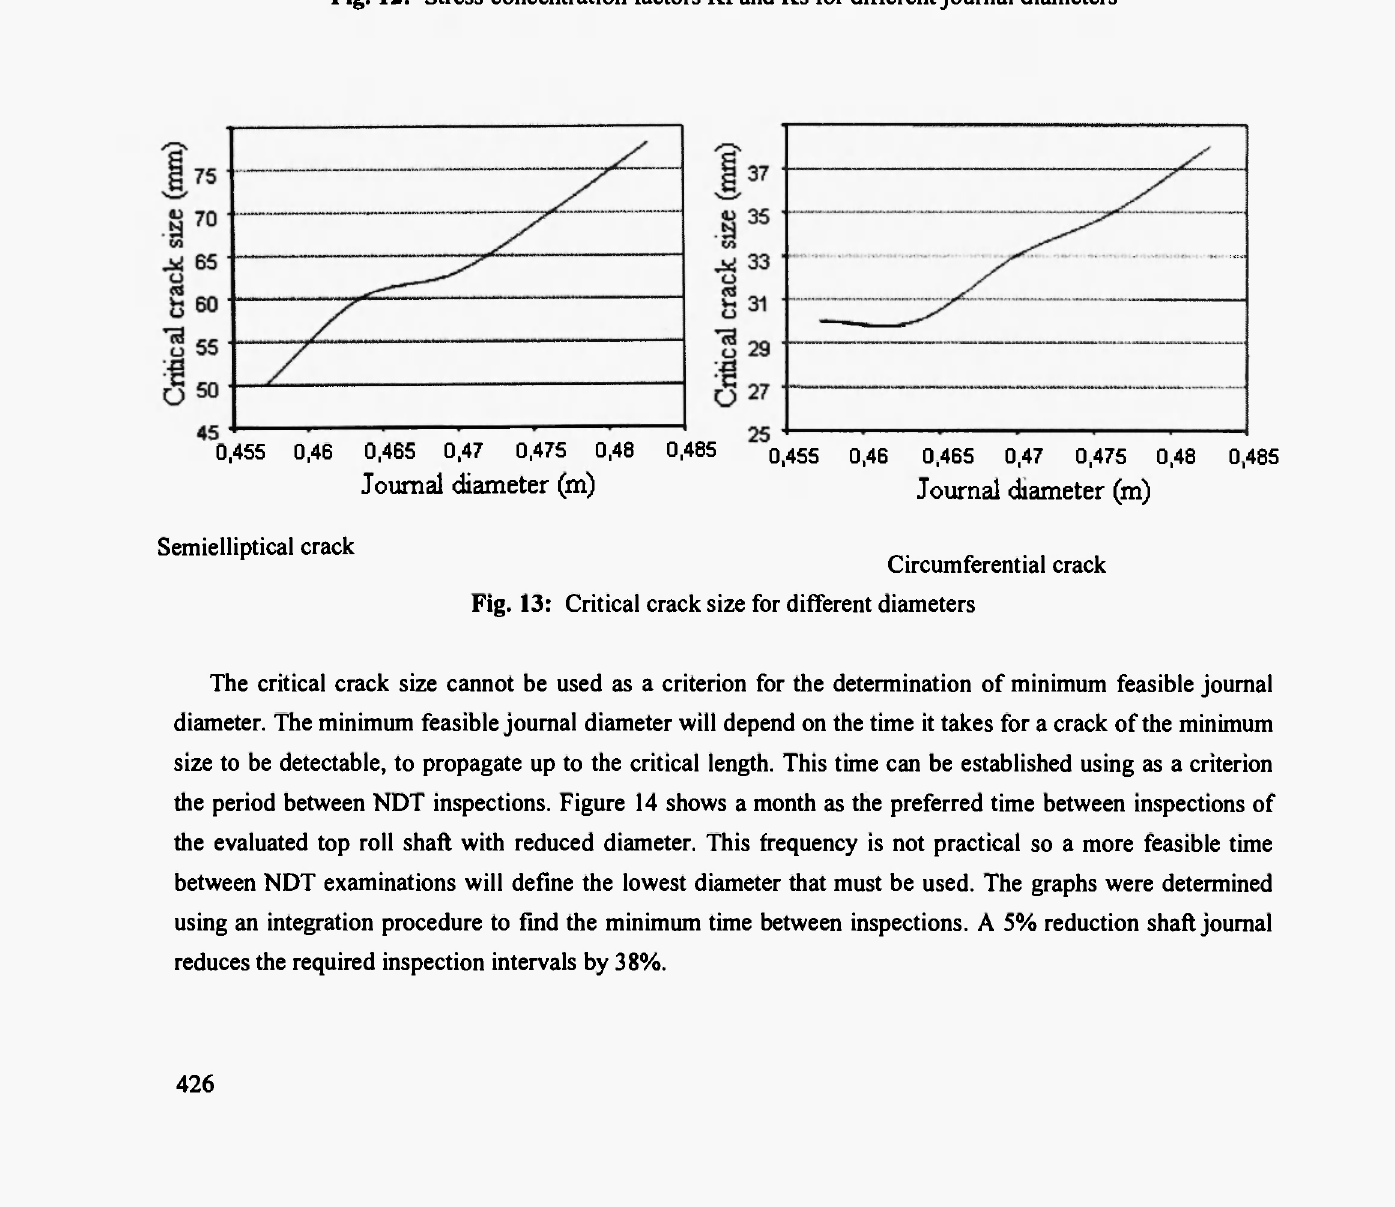
Fig. 12: Stress concentration factors Kf and Ks for different journal diameters